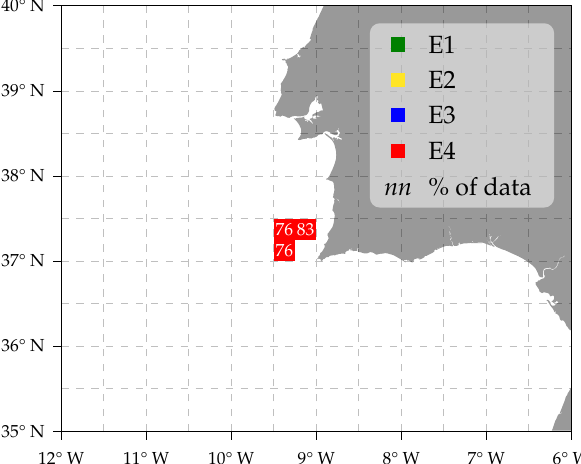
Figure 9. Same as Figure 7, but for each type of event only the labels fulfilling the geographical constraints are kept.